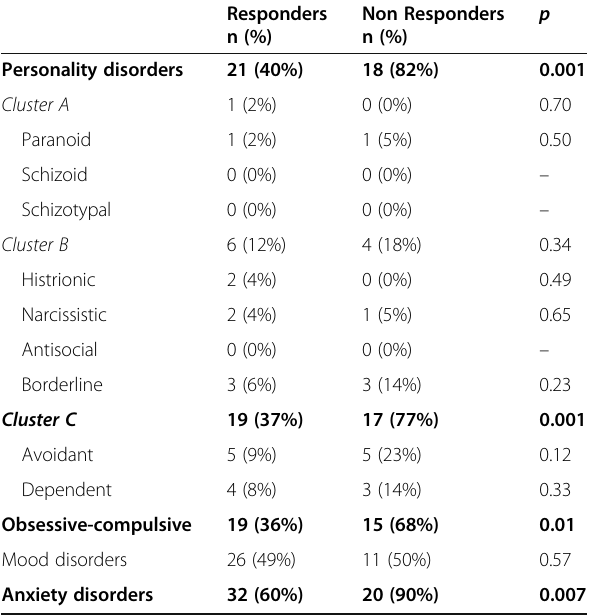
Table 2 Psychological characteristics of the two groups as result from the clinical interview based on